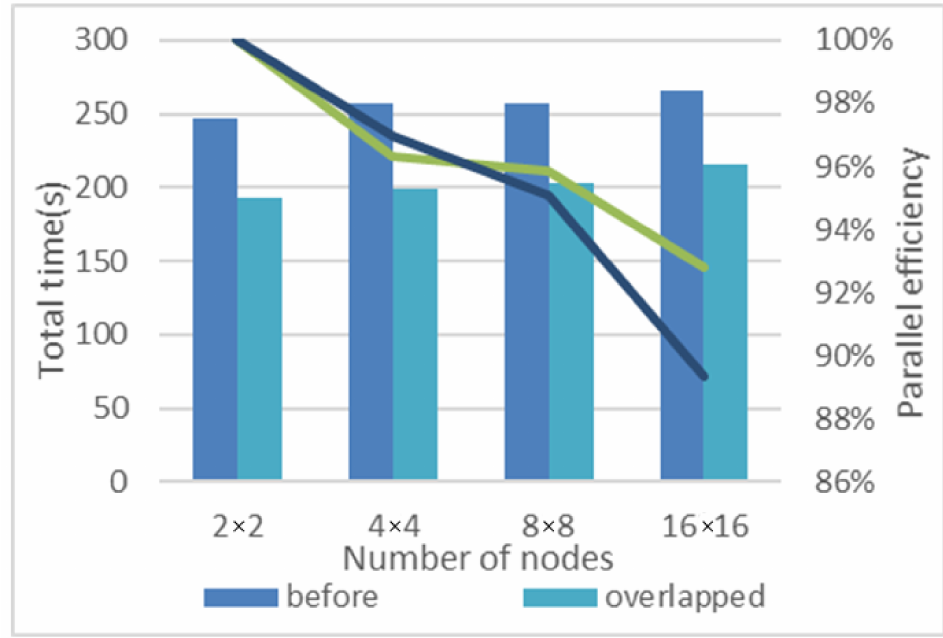
Figure 7. Extended test performance graph for overlapped